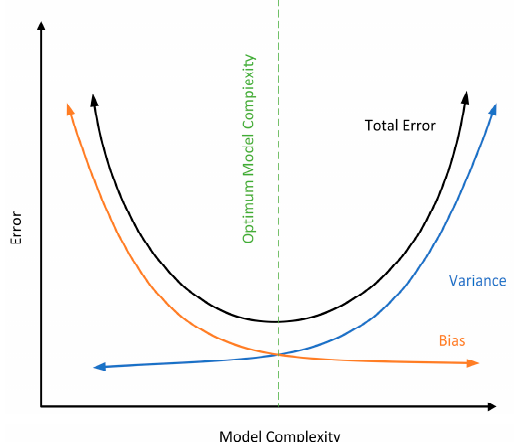
Figure 21. Bias–variance relationship.